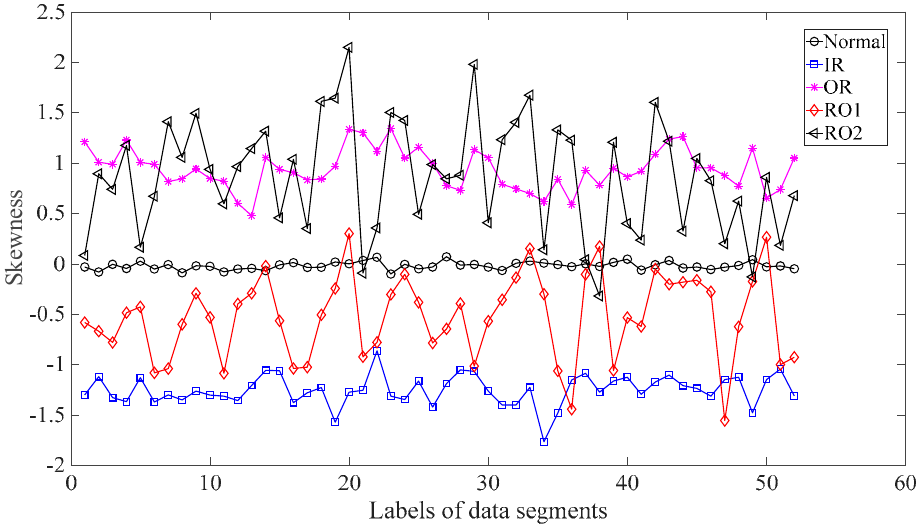
Figure 15. Skewness of the five types of roller-bearing vibration data.